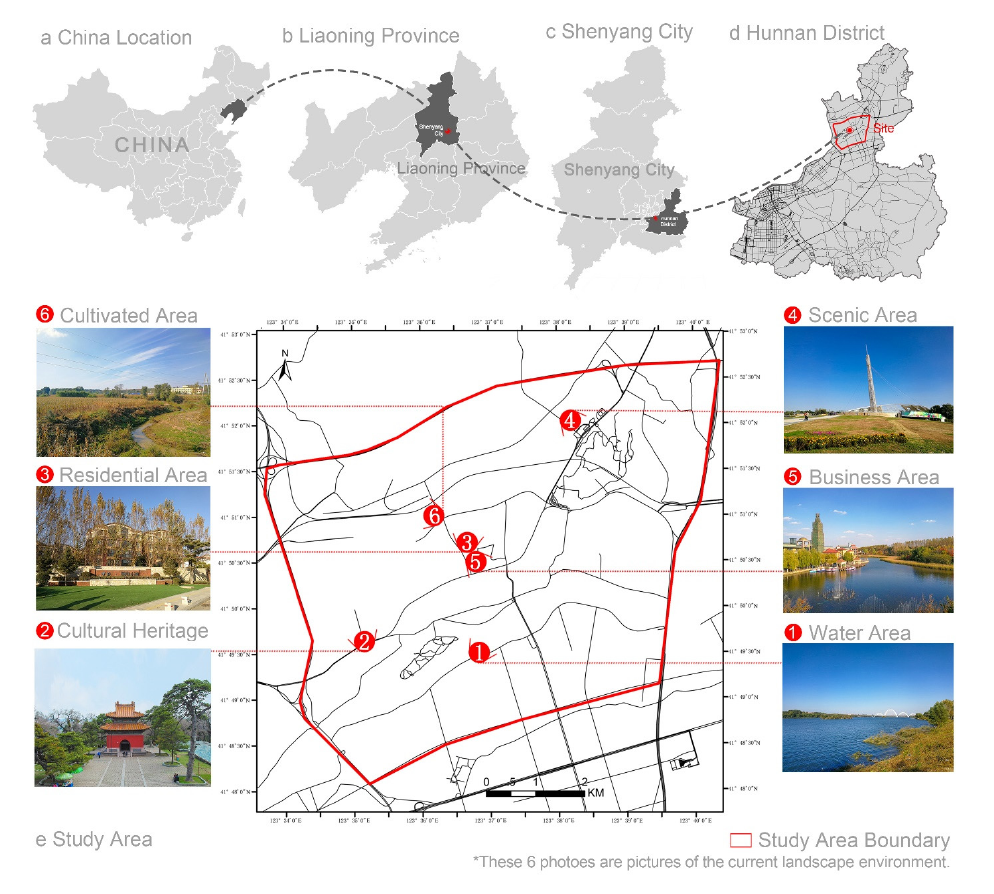
Figure 1. Location of the study